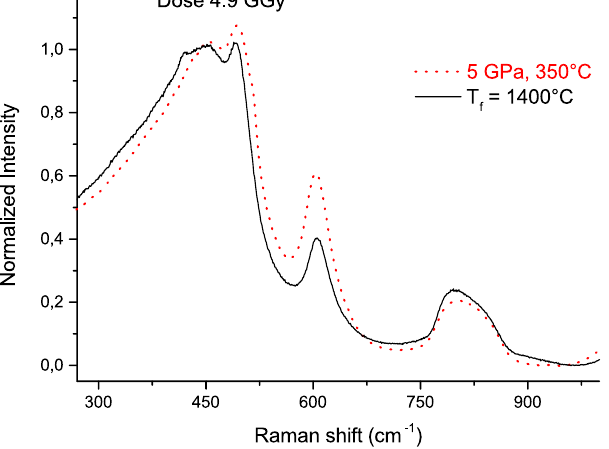
Figure 8. Raman spectra of (5 GPa, 350 °C) and T f = 1400 °C both irradiated at 4.9 GGy displaying a close density